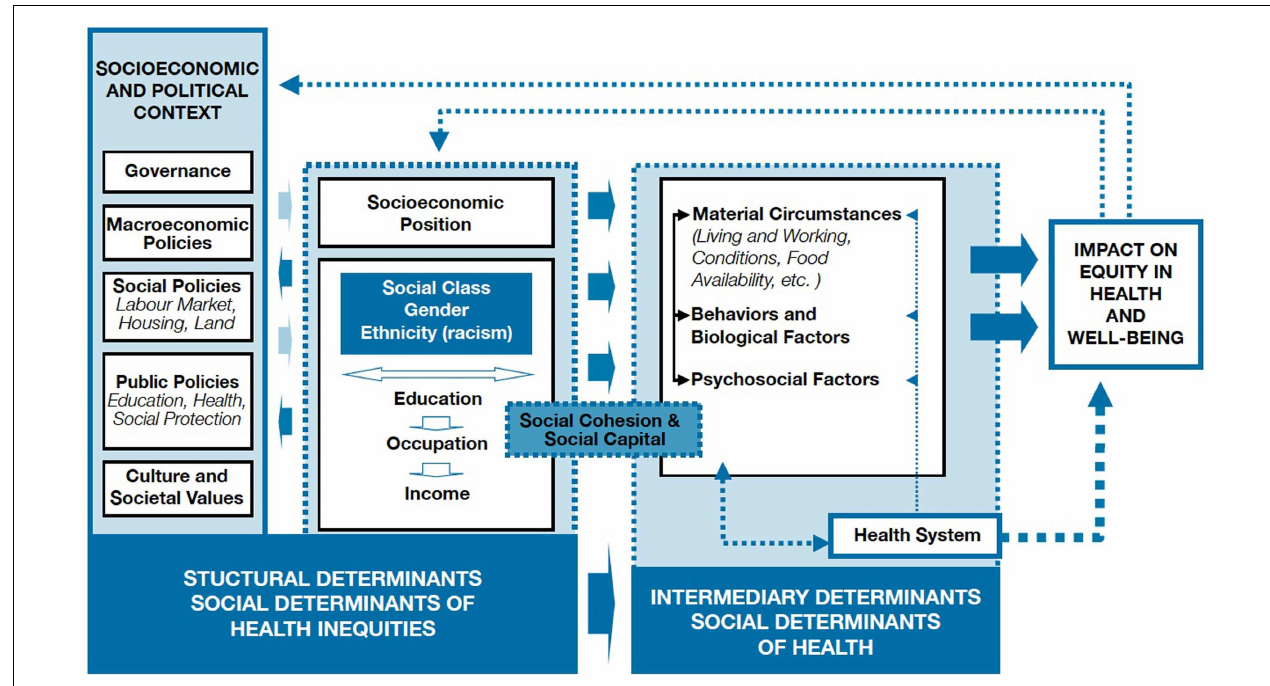
FIGURE 1 |WHO framework of social determinants of health [World Health Organization (WHO), 2010]. Permission was granted to reproduce this diagram as it was originally published by theWorld Health Organization (WHO; 2010) on page 6 in A Conceptual Framework for Action on the Social Determinants of